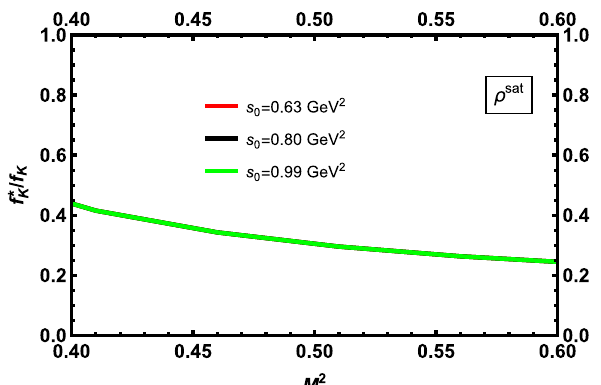
Fig. 5 The same as Fig. 4 but for decay constant of K + meson Table 2 The in-medium mass of kaon at saturation